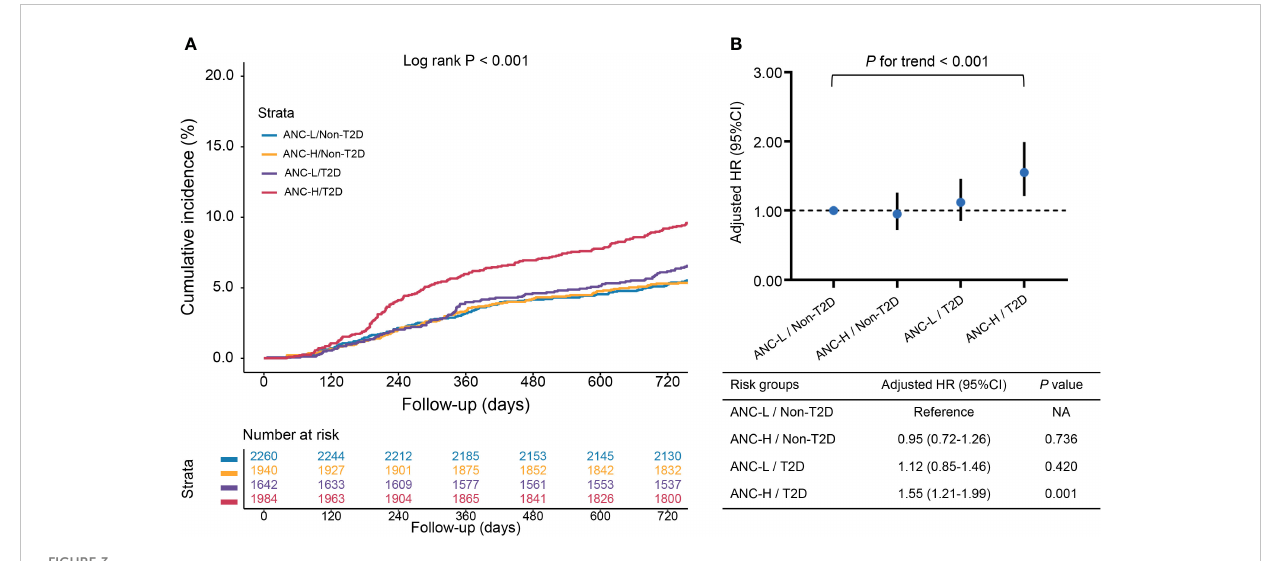
FIGURE 3 The associations of risk groups with the risk of MACCEs. (A) Kaplan – Meier curves for cumulative incidence of MACCEs according to four risk groups; (B) Hazard ratios (HRs) [95% con fi dence intervals (CIs)] for MACCEs according to four risk groups. Model adjusted for age, male sex, BMI, hypertension,